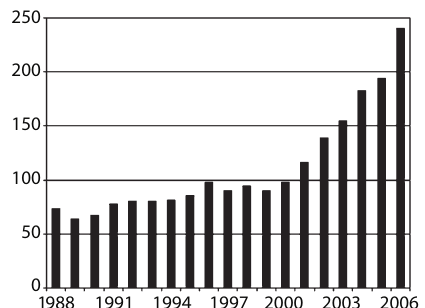
Fig. 1. Number of real-time stations connected to the INGV acquisition system from 1988 to the end of 2006. Most of the stations belong to the RSN but in the last few years stations of MedNet and of neigh- boring countries are also included. The strong im- pulse was given by the INGV-DPC first 3-year agree- ment, in 2001, and is still going